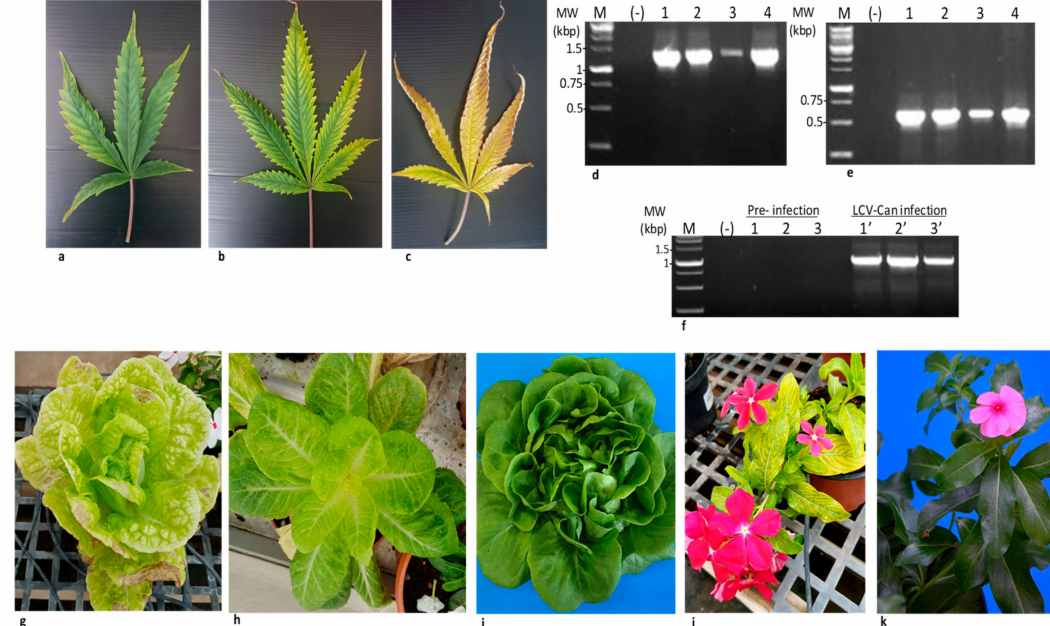
Figure 4. Cannabis lettuce chlorosis virus (LCV-Can) isolate transmitted by B. tabaci MEAM1 biotype to un-infected cannabis, lettuce and rose periwinkle plants. ( a – c ) LCV-Can infected cannabis leaves at three time points post-viral transmission: 21, 45 and 60 days post-inoculation (dpi), respectively. ( d , e ) RT-PCR detection of LCV-Can infected cannabis plants at 35 dpi ( d ) Detection of RNA1 fragment using the primers RNA1-F-7170 and RNA1-R-8433 (Table 3). ( e ) Detection of RNA2 fragment using the primers RNA2-F-7628 and RNA2-R-8189 (Table 3). ( f ) RT-PCR of un-infected and LCV-Can